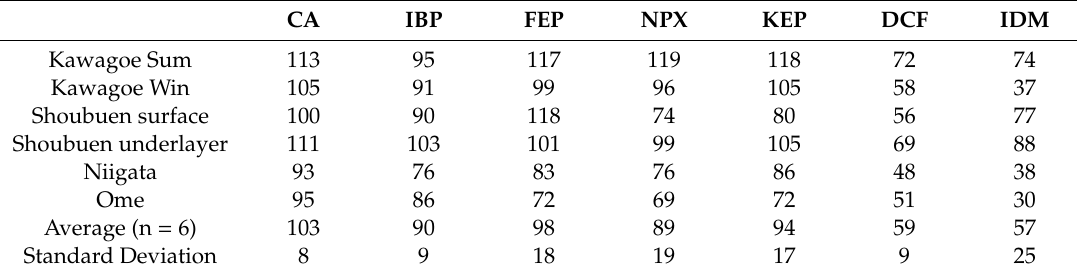
Table 2. The residual ratios (%) of pharmaceuticals in sterile slurry with the sealed caps.